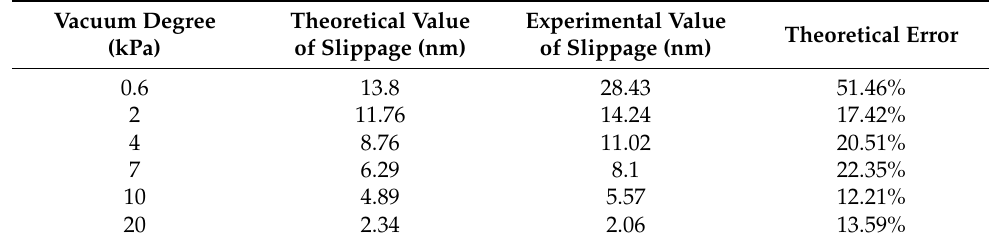
Table 7. Theoretical value, experimental value, and error of slippage (stable deceleration phase to